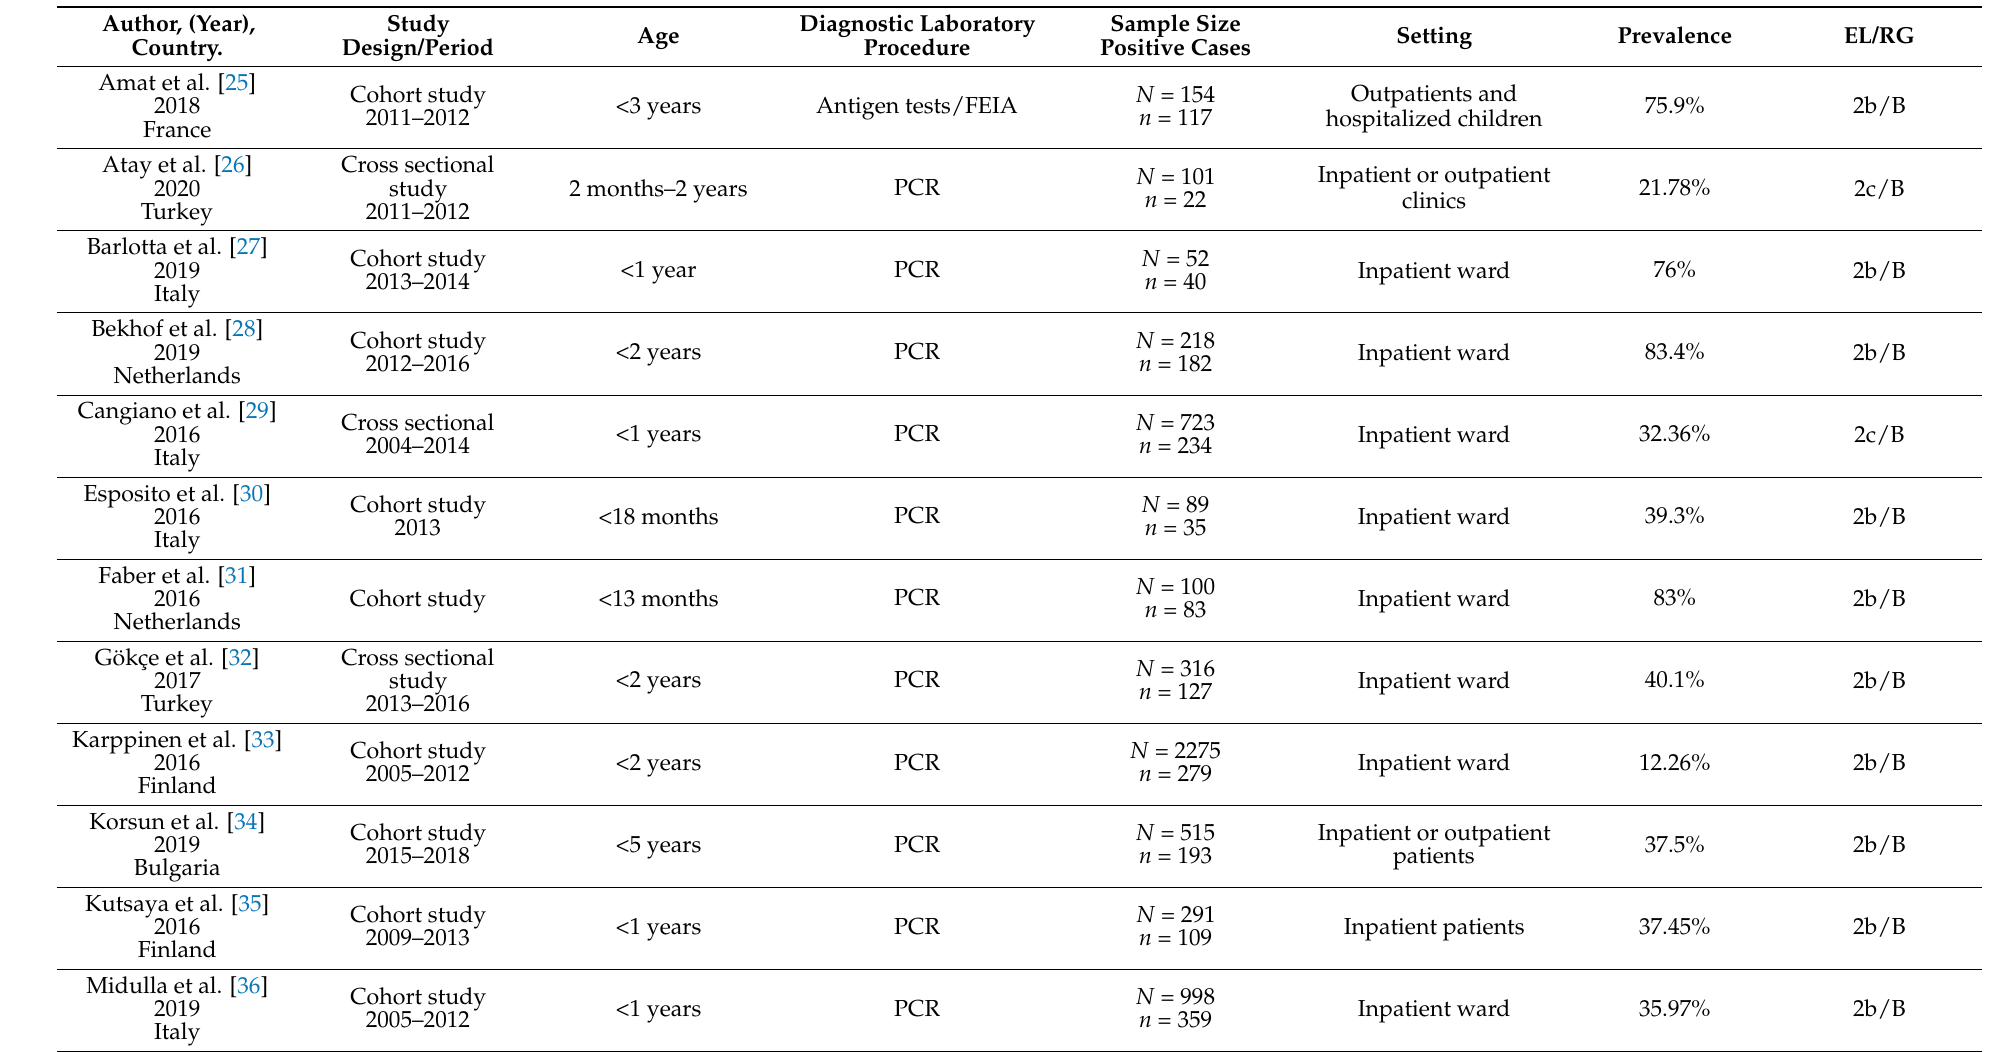
Table 1. Characteristic of included studies ( n =